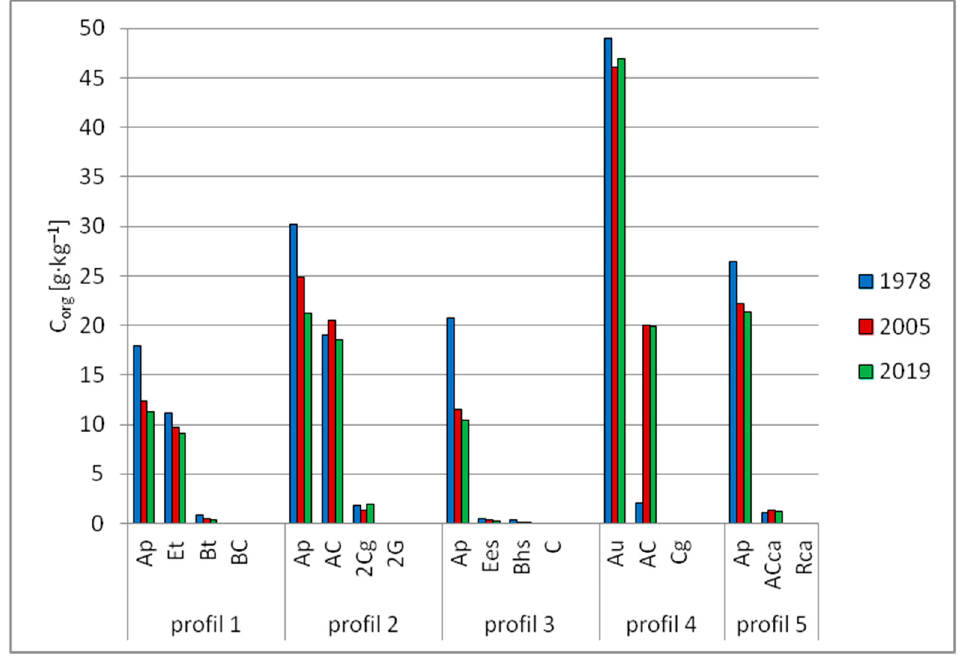
Figure 6. Dynamics of C org (g . kg − 1 ) content in individual horizons of the analysed soils between 1978 and 2019.